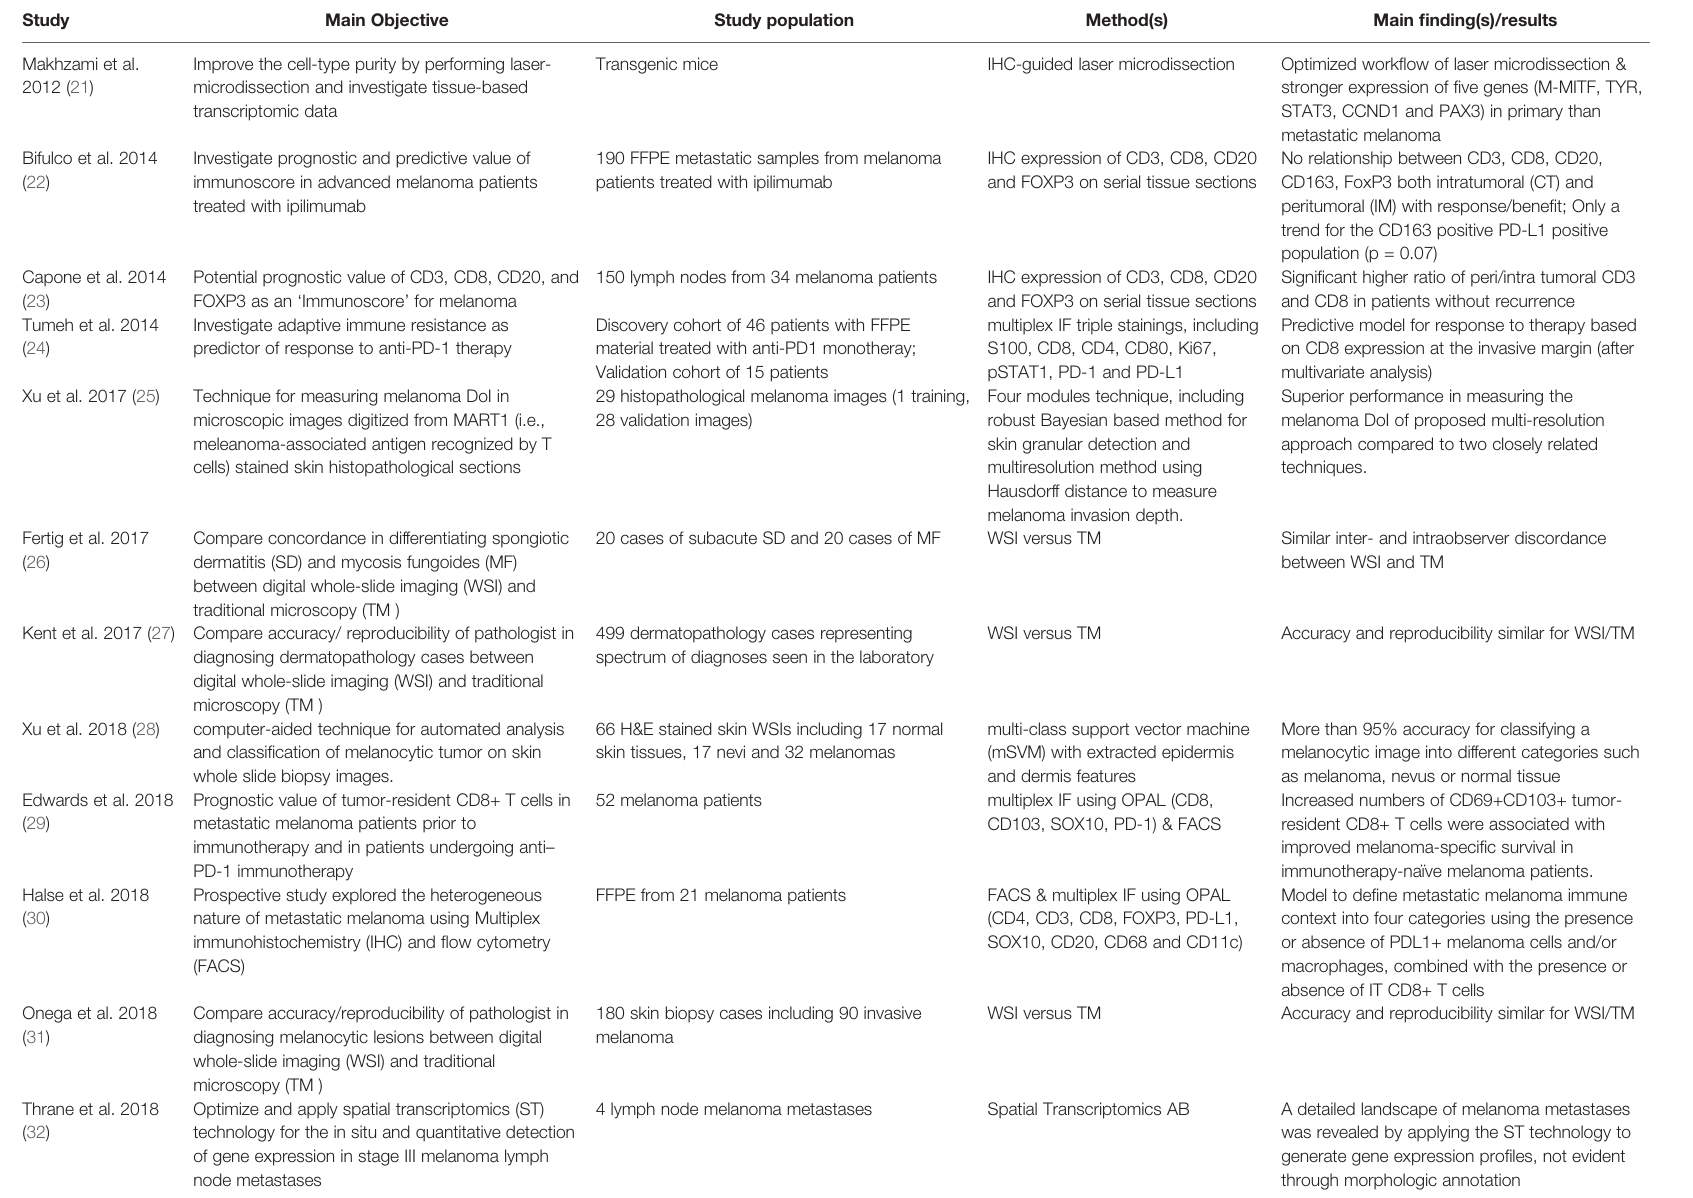
TABLE 1 | Overview of recent studies using digital pathology in melanoma. All studies are ordered according to time of